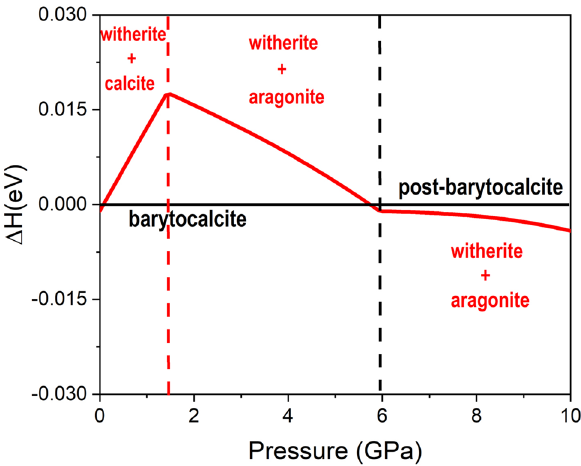
Figure 7. Calculated enthalpy difference between the mixture of single carbonate phases (BaCO 3 + CaCO 3 ) and the most stable phase for the double BaCa(CO 3 ) 2 as a function of pressure. Relevant polymorphs at each pressure were